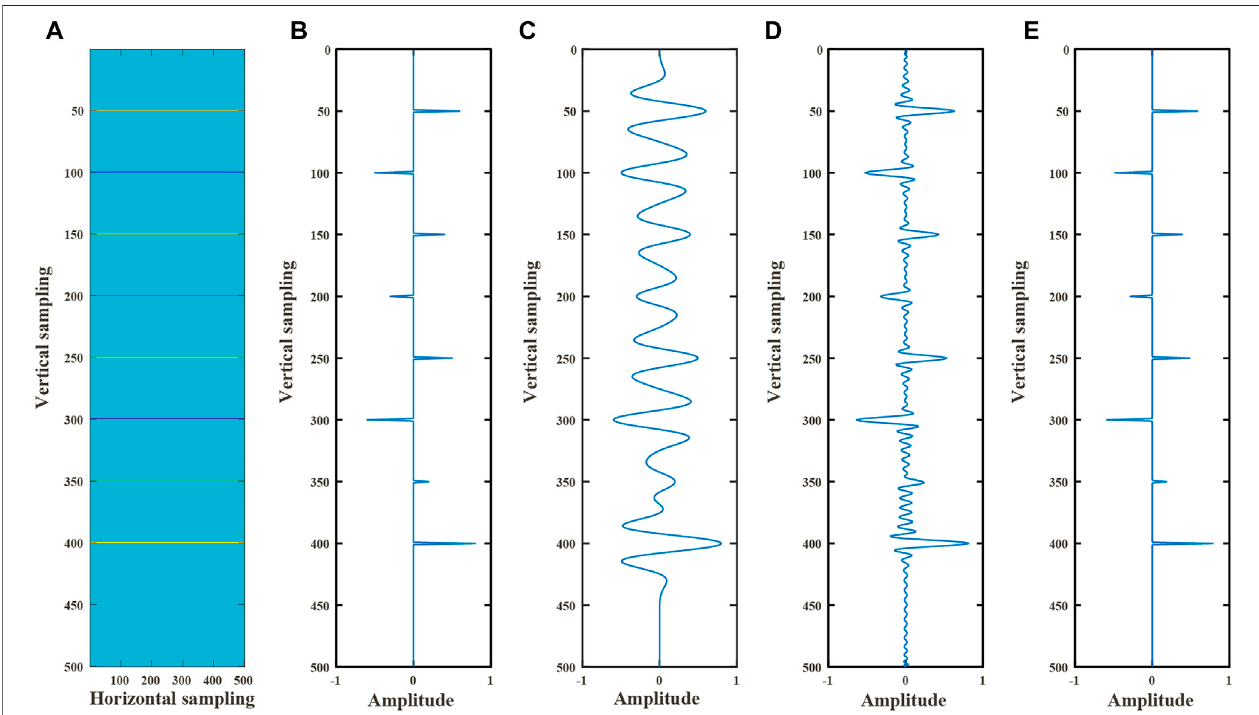
FIGURE 2 | (A) re fl ectivity model; (B) re fl ection coef fi cient series extracted in Figure 2A ; (C) deconvolution of single record; (D) the result inverted by LSM; (E) the result inverted by sparse constrained LSM.